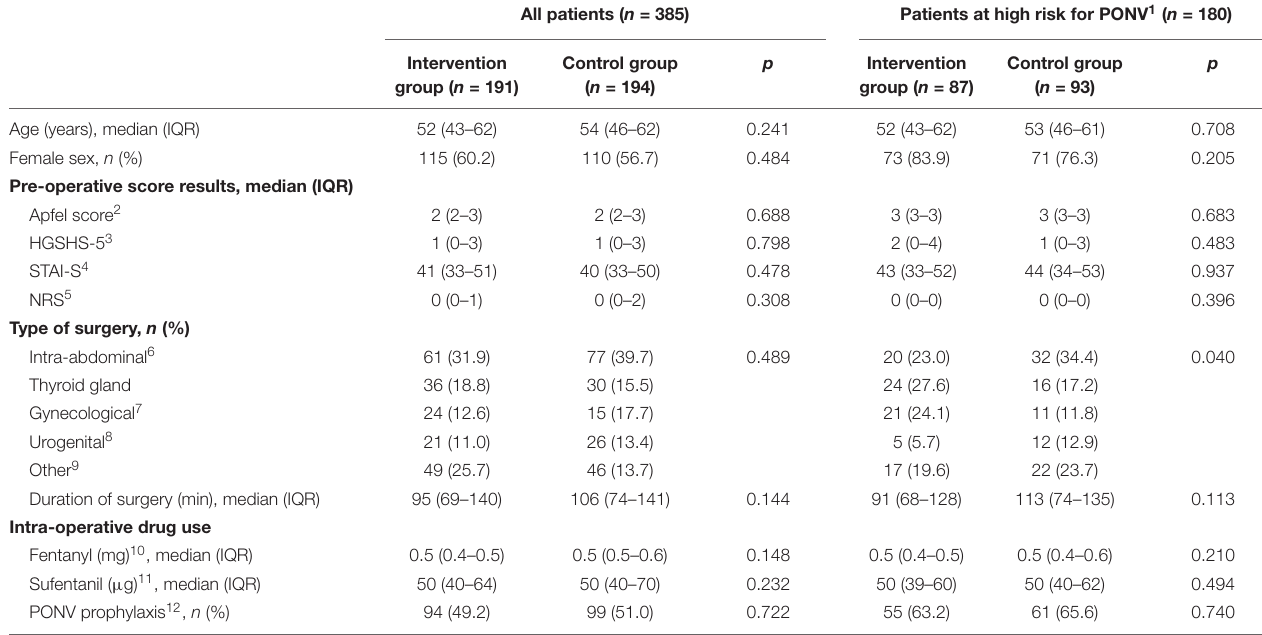
TABLE 1 | Baseline characteristics for all patients and subgroup of patients at high risk for postoperative nausea and vomiting, defined by pre-operative Apfel-score of 3 or 4.